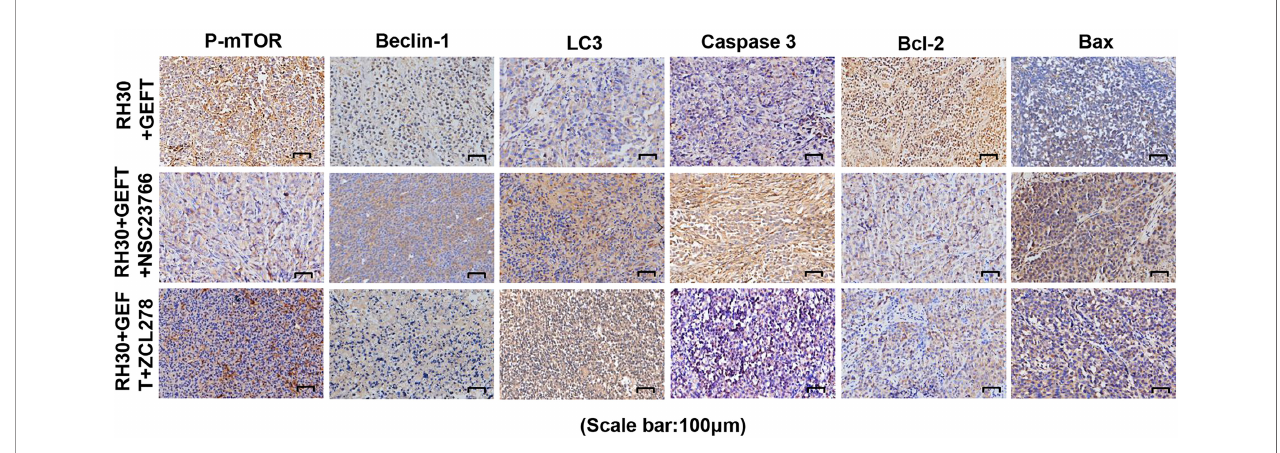
FIGURE 8 | GEFT-mediated Rac1 and Cdc42 inhibit the expression levels of autophagy- and apoptosis-related proteins in transplanted tumor tissues. The expression levels of p-mTOR, Beclin1, LC3, Caspase-3, Bcl-2 and Bax in RH30 transplanted tumor tissues were detected by immunohistochemistry in the RH30+GEFT, RH30+GEFT + NSC23766, and RH30+GEFT + ZCL278 groups. A representative image is provided.